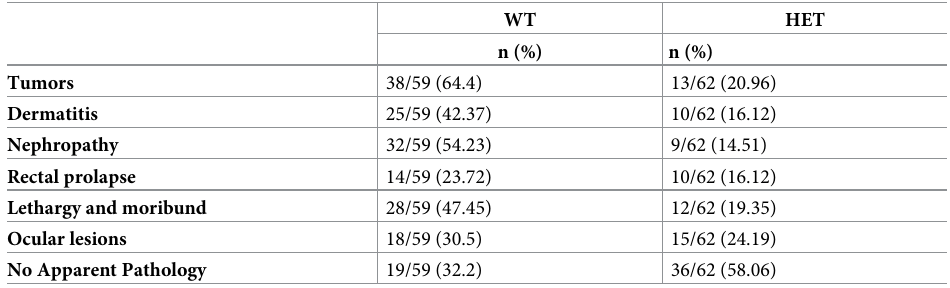
Table 3. Major contributing causes of death in mice evaluated at end of